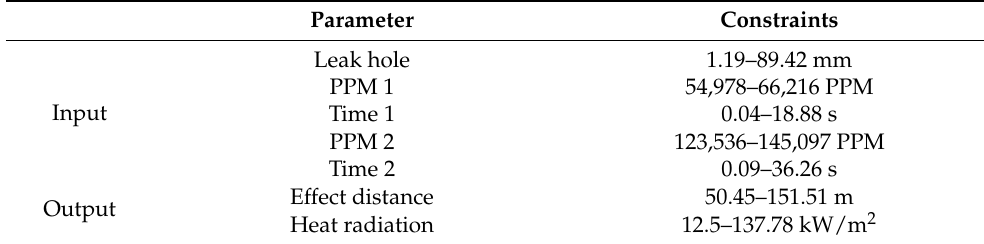
Table 3. Input and output data (consequence prediction